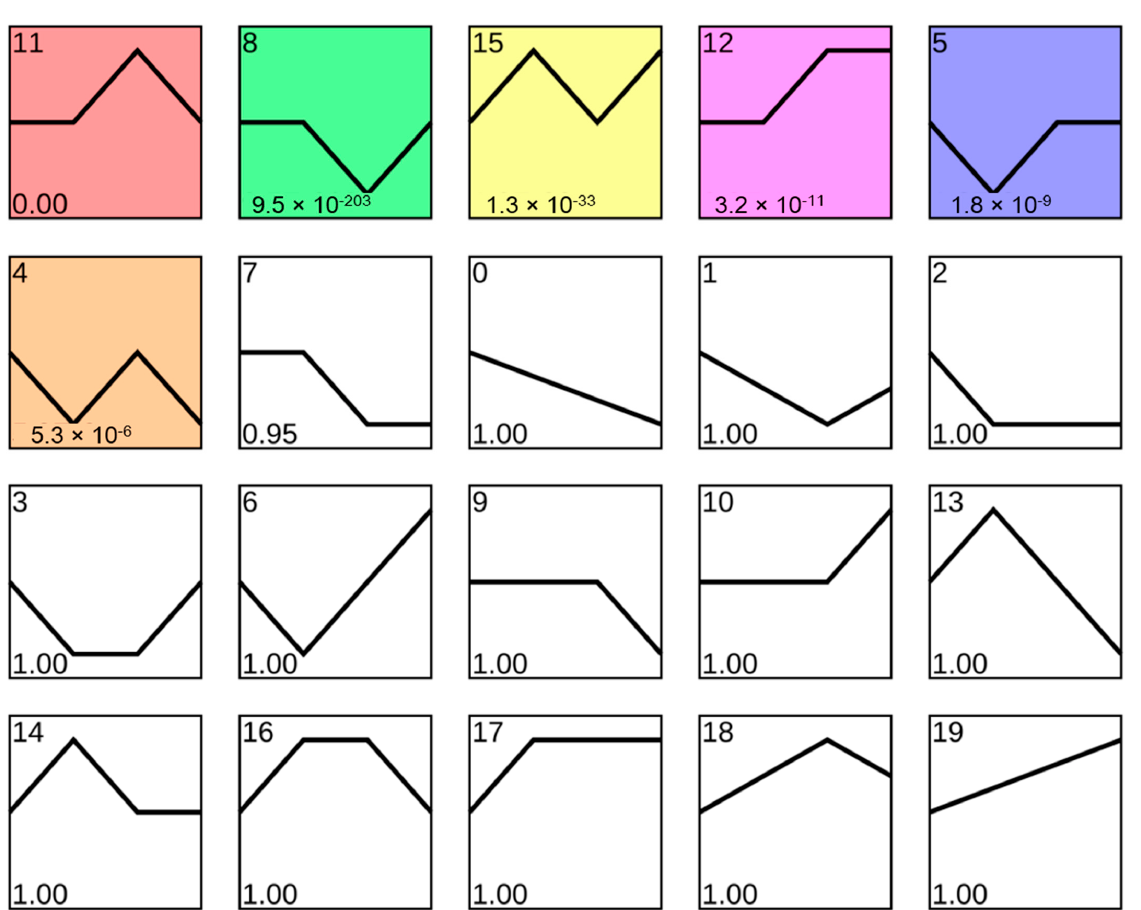
Figure 5. Analysis of the gene trends. We obtained expression patterns of time-series genes at vari- ous times. The colored profiles represent significant profiles. times. The colored profiles represent significant